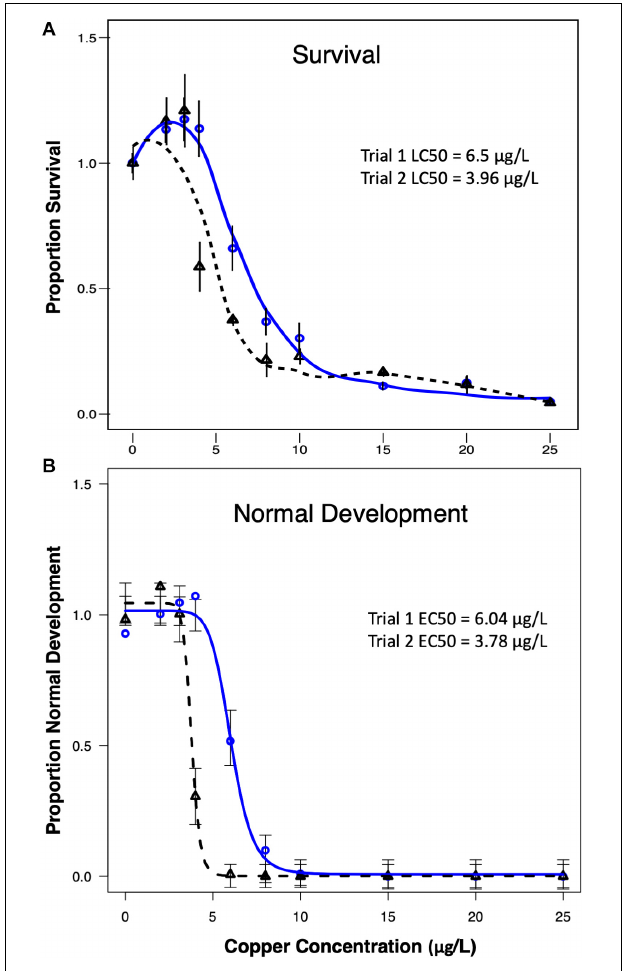
FIGURE 1 | Control-normalized survival (A) and normal development (B) were plotted against copper concentration for trial 1 (blue line) and trial 2 (dashed black line). Data indicate that larvae were slightly more sensitive to copper in trial